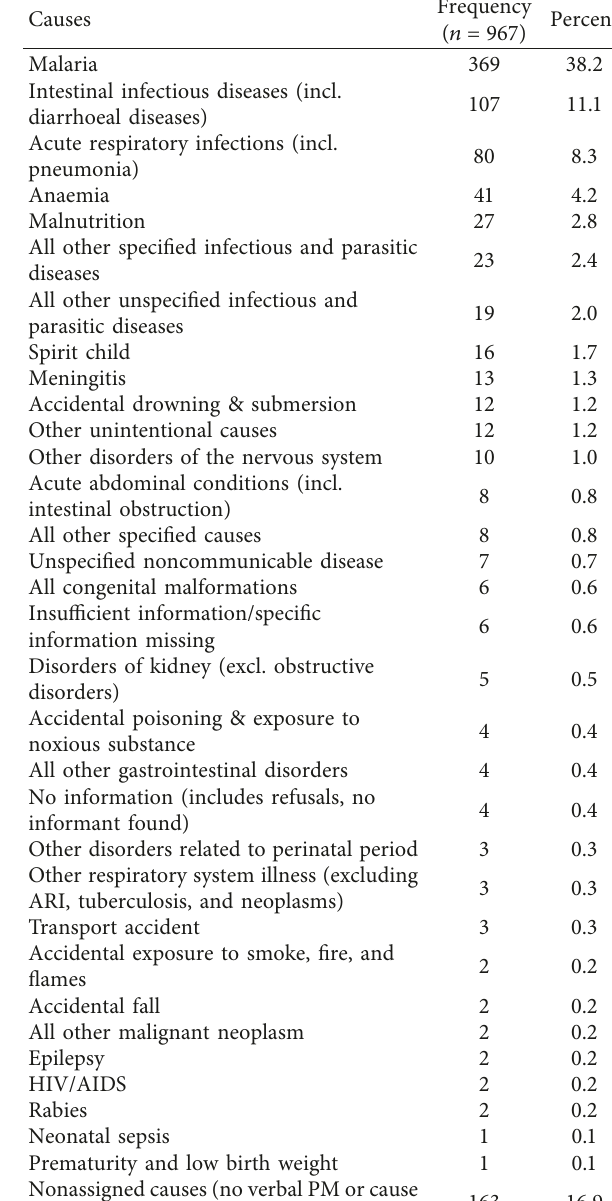
Table 1: Descriptive data on background characteristics of children and mothers ( N � 15745).